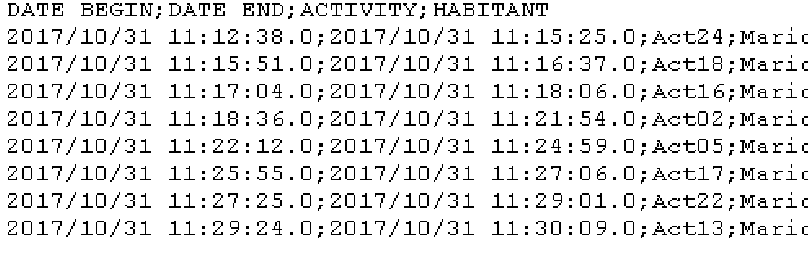
Figure 4. Excerpt from the file